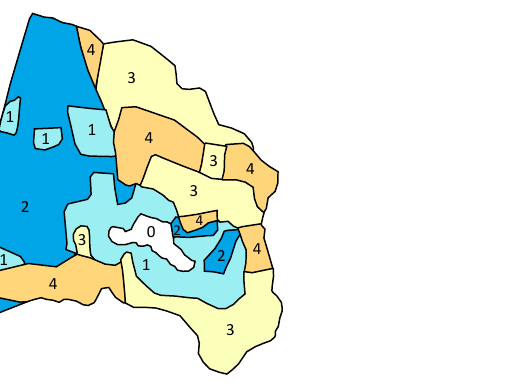
Figure 3. Configuration of the groundwater flow model and lake modules. ( a ) Plain view of the model domain: horizontal discretization, boundary conditions and observation wells. ( b ) Side view of the model domain at A–A ′ for LAK3: vertical discretization, hydrogeological units and lake grid cells. ( c , d ) Side view of the model domain at A–A ′ for the SLM: vertical discretization, hydrogeological units and grid cells with four layers (SLM ‐ TS4) and one layer (SLM ‐ TS1).